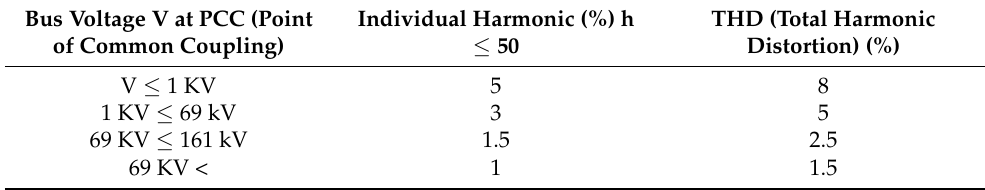
Table 6. Voltage distortion limits